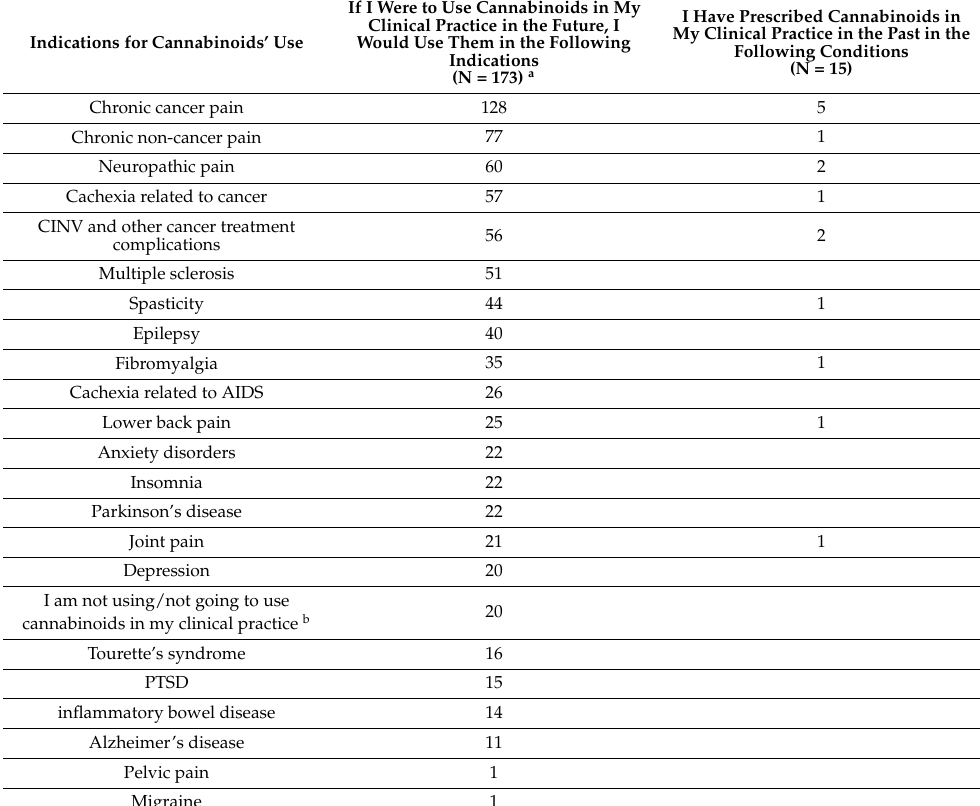
Table 3. Indications for cannabinoids’ use according to survey participants.